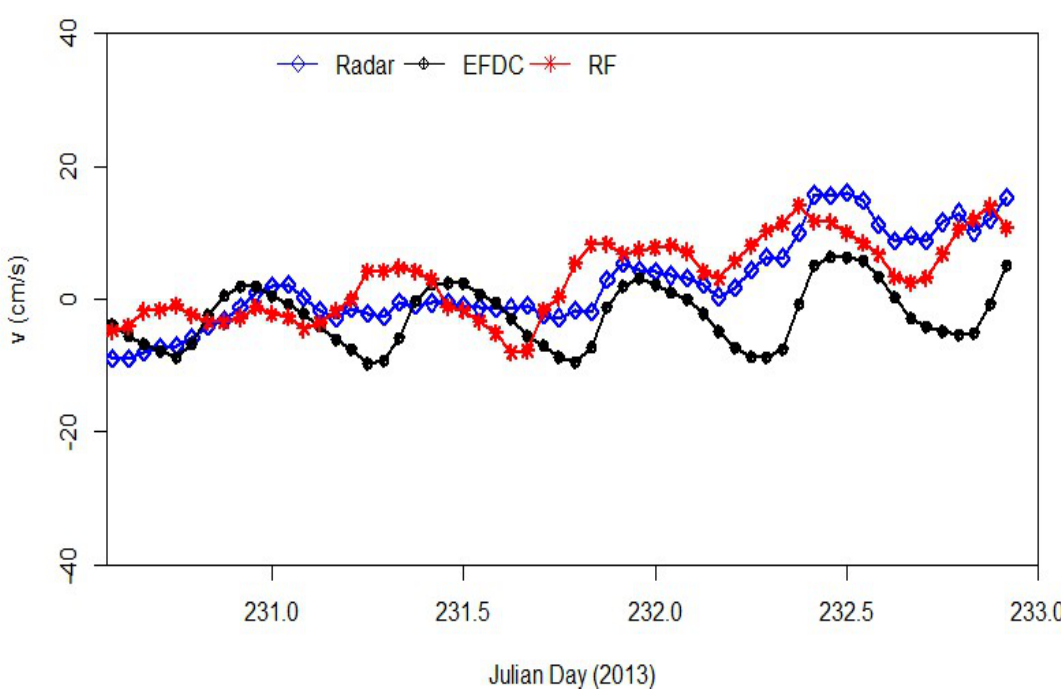
Figure 5. Predictions of zonal surface velocity component at point P2. Figure 6. Predictions of meridional surface velocity component at point Figure 4. Predictions of meridional surface velocity component at point P1.